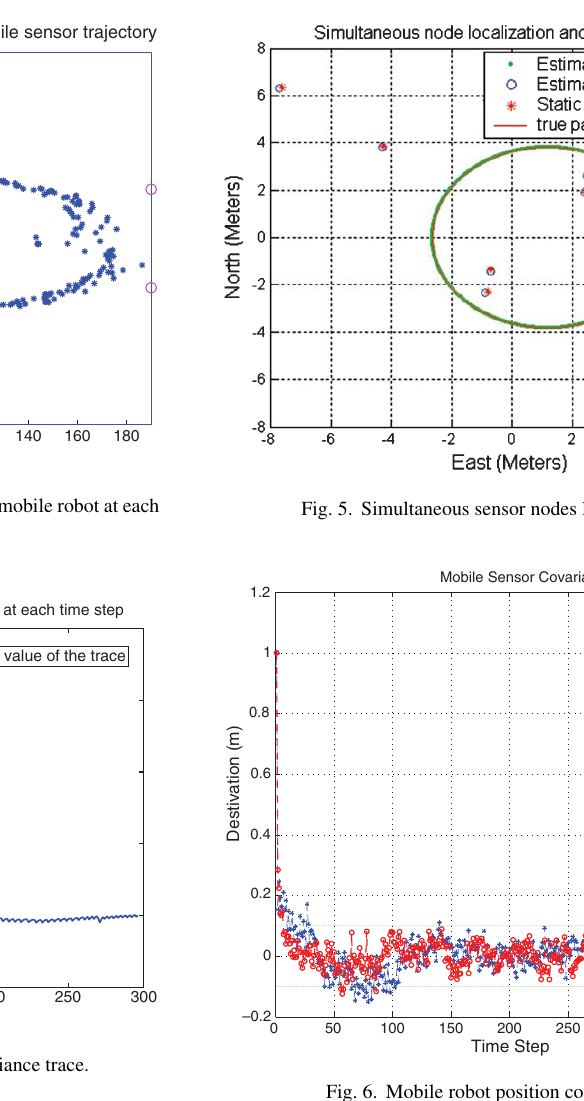
Fig. 6. Mobile robot position